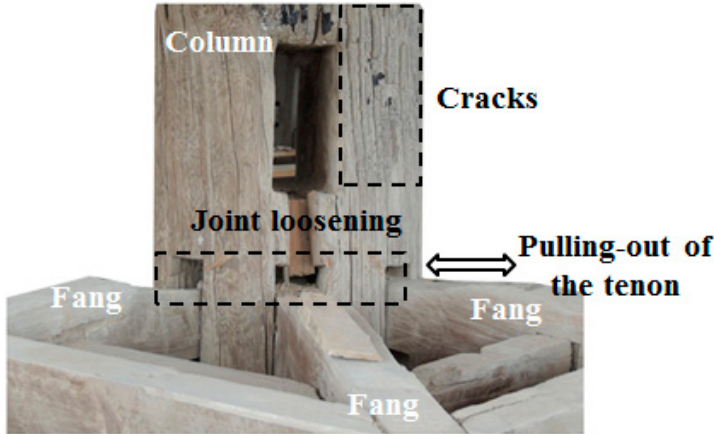
Figure 1. Feiyun Wood Pavilion.